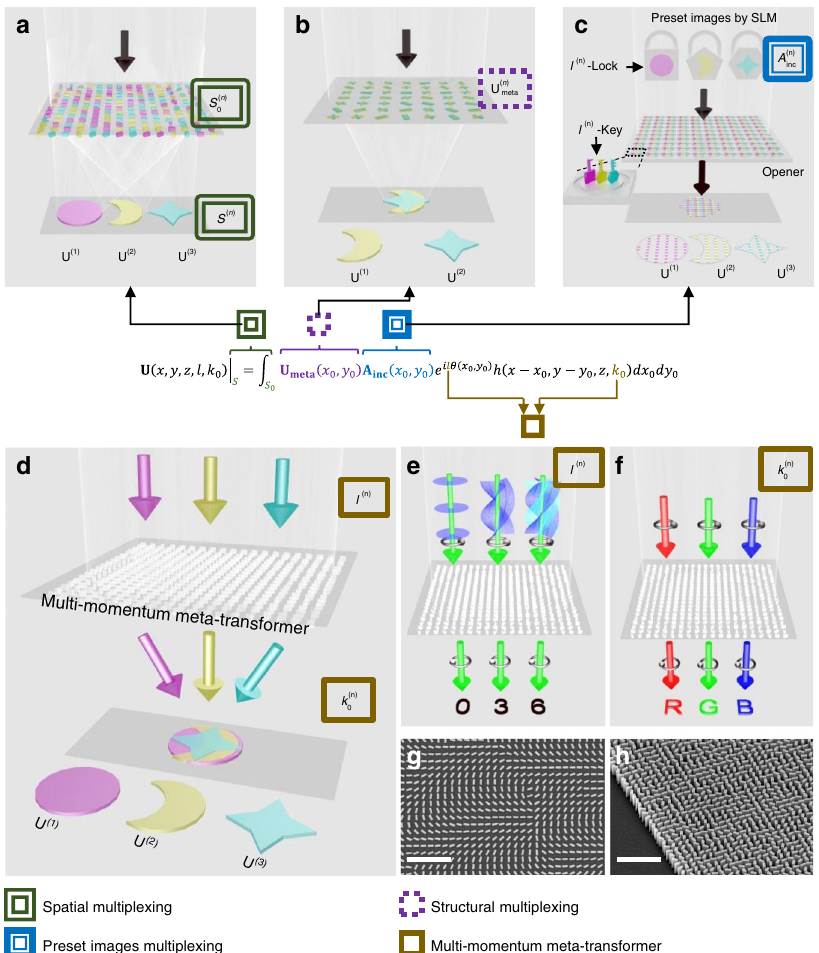
Fig. 1 Comparative elaborations of multi-tasked metasurfaces ( a – c ) and our multi-momentum meta-transformer ( d – h ). a Schematic illustration of a spatially multiplexed metasurface 21 – 29 . The spatial multiplexed metasurface reconstructed several distinguished fi eld distribution U ð n Þ based on the spatial (cid:2) (cid:3) or observed region ( S ( n ) ). The x 0 and y 0 ( x , y , and z ) are the coordinated variables of the metasurface plane S 0 separations of metasurface S ð n Þ 0 (observation region S ). b Illustration of a structurally multiplexed metasurface 30 – 34,37,38 . The structurally multiplexed metasurface reconstructed several distinguished fi eld distribution U ð n Þ based on the metasurface function U ð n Þ meta . c Schematic illustration of a multi-beam meta-opener 39 . The multi-beam meta-opener is formed by several kinds of “ key arrays ” , which is used to read out the distributions U ð n Þ carried by the preset incident beams. d Illustration of transmission-type multi-momentum meta-transformer. The multi-momentum meta-transformer decoder phase pro fi le is implemented with TiO 2 nano- fi n array with in-plane orientations on a quartz substrate. It controls multi-beams with different momenta ( l ( n ) and k n ð Þ ) to reconstruct corresponding fi eld 0 distributions U ð n Þ Schematic of the OAM meta-transformer. Under the illumination of vortex beams with right circular polarization (RCP), the decoder can generate distinct images at the same plane with left circular polarization (LCP). f Schematic of the LM meta-transformer. Under the illumination of different LM beams with RCP, the meta-transformer can generate distinct LM-dependent fi eld distributions at the same region on optical axis. g Top-view scanning electron microscopy (SEM) images of a partial region of the fabricated TiO 2 nano- fi ns arrays. Scale bar: 2 μ m. h Oblique-view SEM image. Scale bar: 2 μ m. Each TiO 2 nano- fi n represents a phase pixel as de fi ned in the